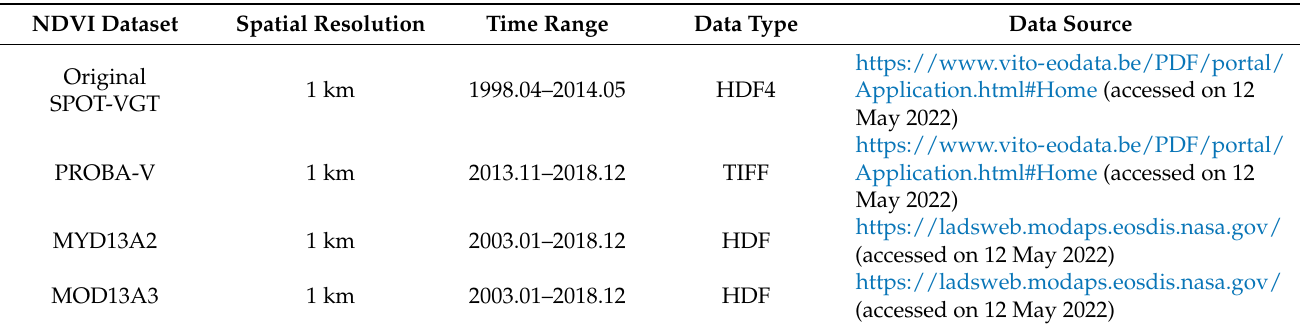
Table 1. Description and source of